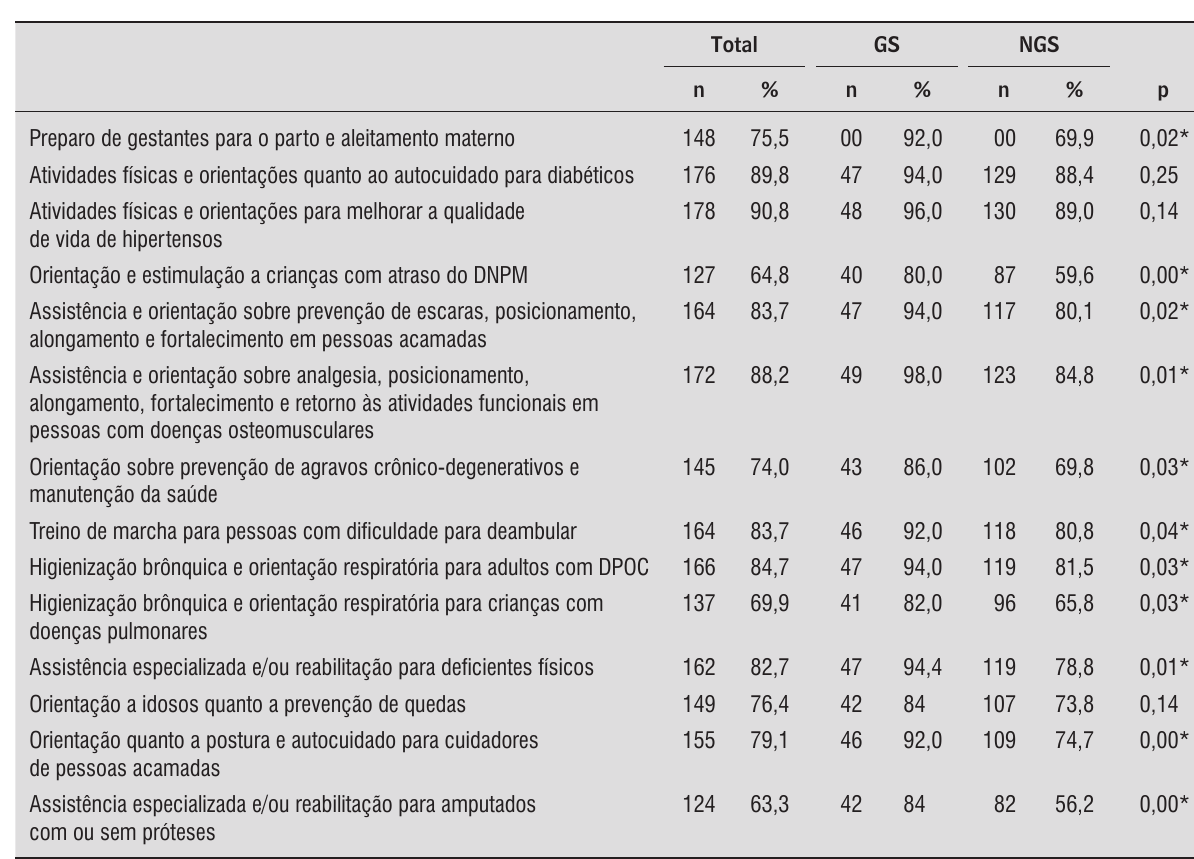
identificadas pela totalidade dos trabalhadores que constituem as equipes da ESF e pelos grupos de